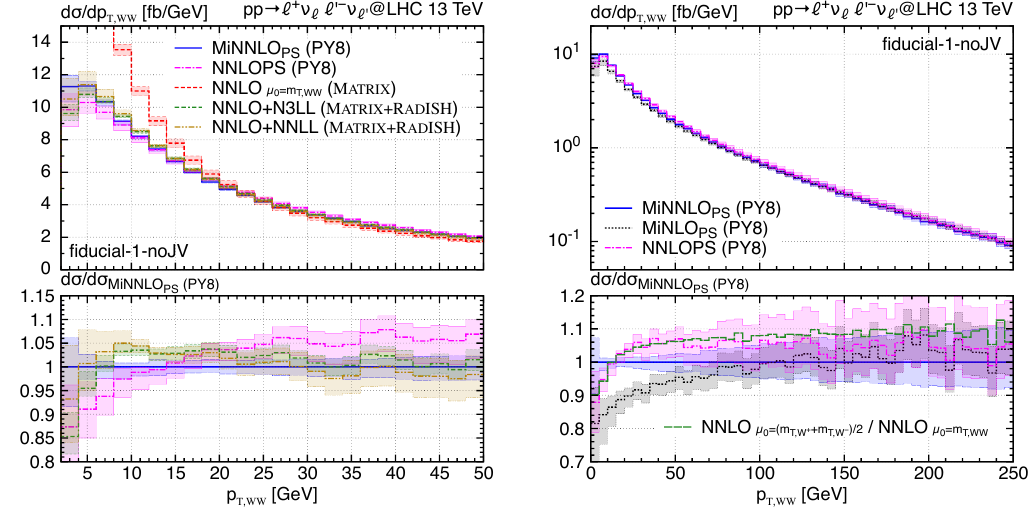
Figure 9. Distribution in the transverse momentum of the W + W (cid:0) pair in the fiducial-1-noJV phase space, showing a smaller (left plot) and a wider range (right